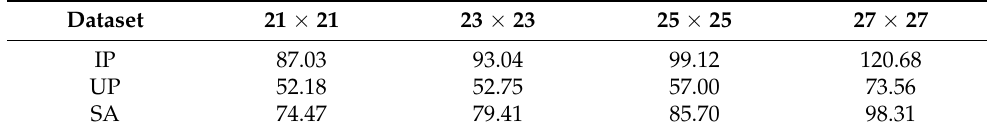
Table 5. The total training and testing time of different window sizes